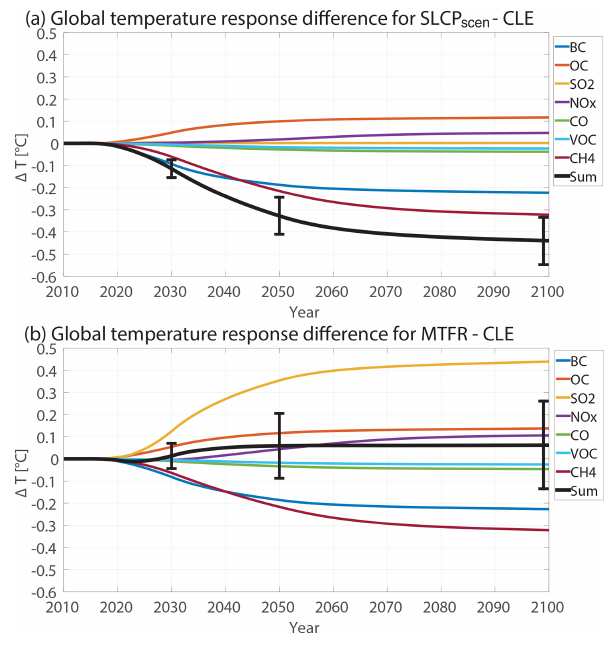
Figure 2. Global temperature response due to the (a) SLCP scen and (b) MTFR scenarios relative to the baseline CLE scenario. Fu- ture global temperature change will also be impacted by historic and baseline emissions which are not accounted for here. Error bars representing 1SD (standard deviation) are given for the net response in 2030, 2050, and 2100. They are calculated based on literature val- ues for Gaussian uncertainties in per-component RF, assuming no interspecies correlation, and estimated using a Monte Carlo analy- sis (100000 pulls), where component forcing values are drawn from within the uncertainty